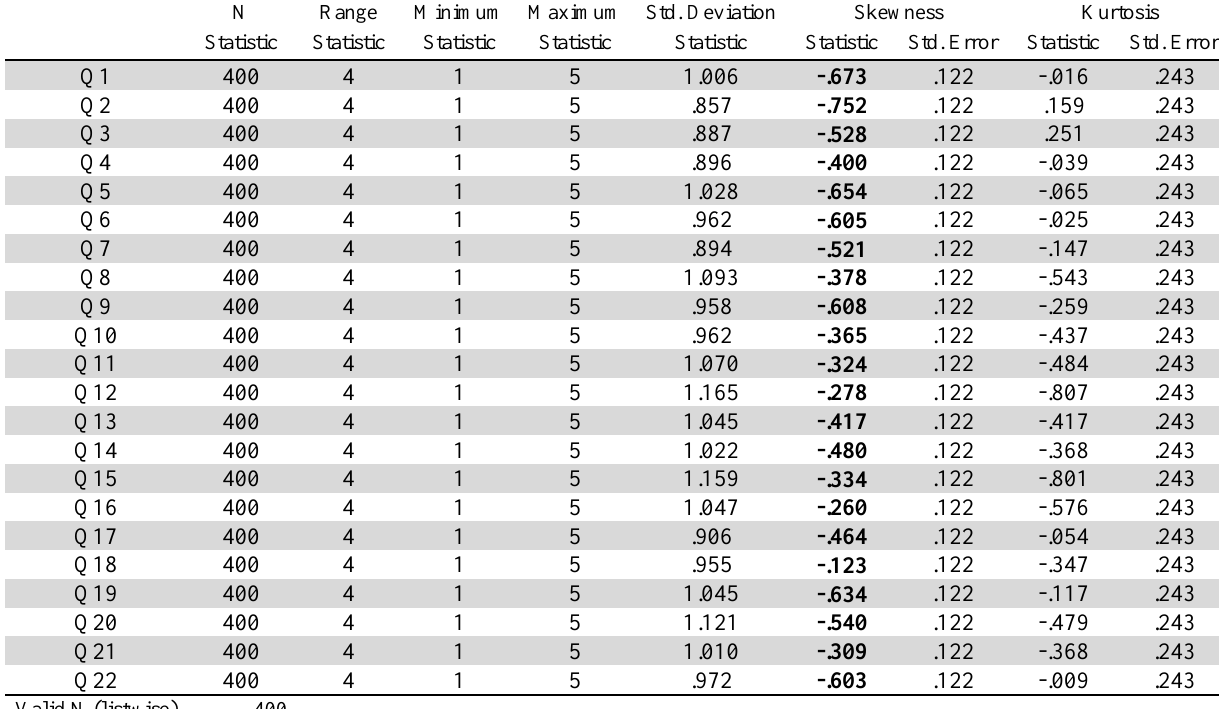
Table 1 The summary of basic descriptive statistics